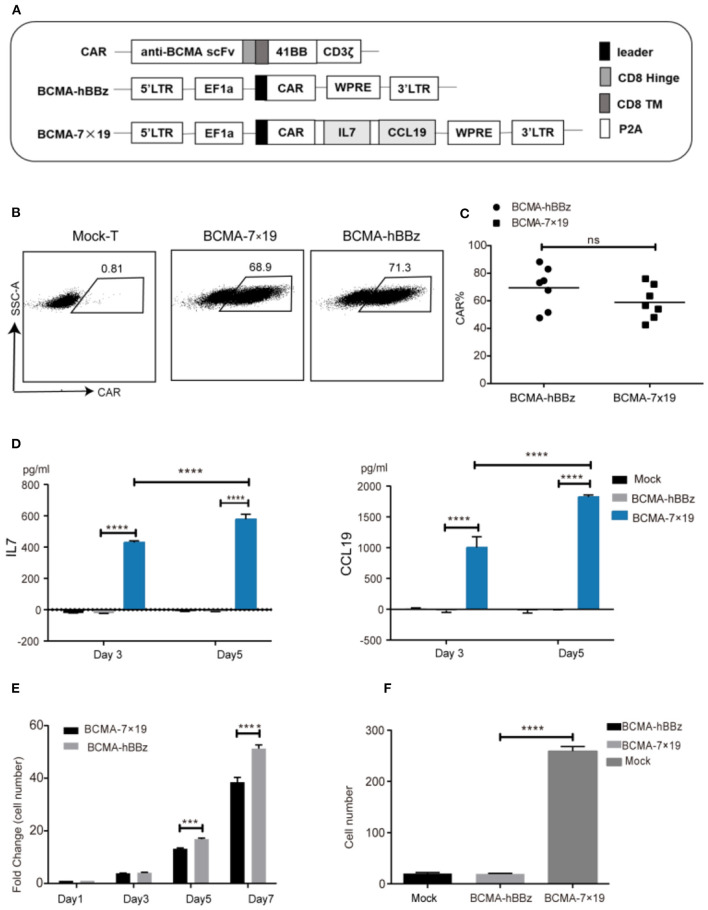
Efficient expression of CAR on lentiviral-transduced T cells and functional verification of IL-7 and CCL19. (A) Schematic representation of BCMA-hBBz CAR and BCMA-7x19 CAR. (B) CAR expressions of CAR-T cells were analyzed by flow cytometry. The numbers in scatter plots represent the percentages of positively stained cells. (C) The expression rates of BCMA CAR and BCMA-7x19 CAR. Data are means± SD obtained from seven donors. MOI = 80. P-value was calculated by two-tailed student t-test. ns, not statistically significant (P > 0.05). (D) Quantitative detection of IL-7 (left) and CCL19 (right) secretion by ELISA. (E) Number fold change of BCMA-hBBz and 7 × 19 CAR-T cells at the indicated time-points. ****P < 0.0001 by two-way ANOVA. (F) The count of migrating T cells (N = 3). ****P < 0.0001 was calculated by two-tailed student t-test. ***P < 0.001.